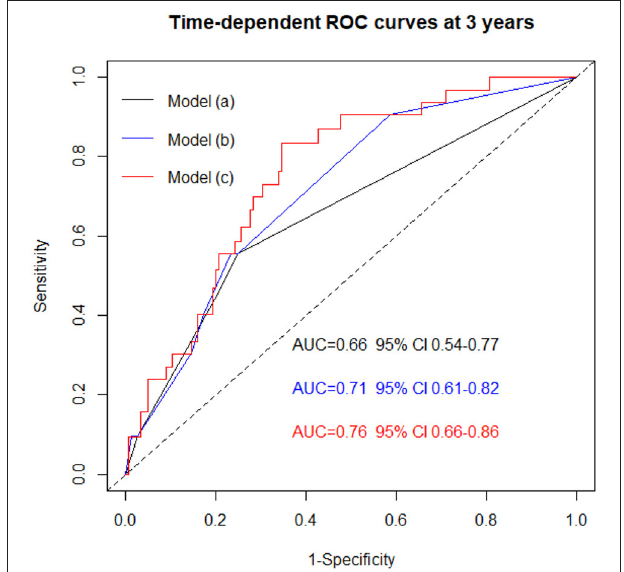
FIGURE 2 | Time dependent ROC curves showing the progressive incremental power of CMR analysis in predicting MACEs when adding LGE (model b) and LGE + RV-GLS (model c) to clinical model (i.e., model a: NYHA III-IV + sinus rhythm). The three models are derived from the multivariable analysis is showed in Table 3 . Model a vs. Model b, p = 0.03. Model a vs. Model c, p = 0.01. Model b vs. Model c, p = 0.03. AUC, area under the curves; CMR, cardiac magnetic resonance; LGE, late gadolinium enhancement; MACEs, major cardiovascular events; NYHA, New York heart association; ROC, receiver operating curves; RV-GLS, right ventricular global longitudinal